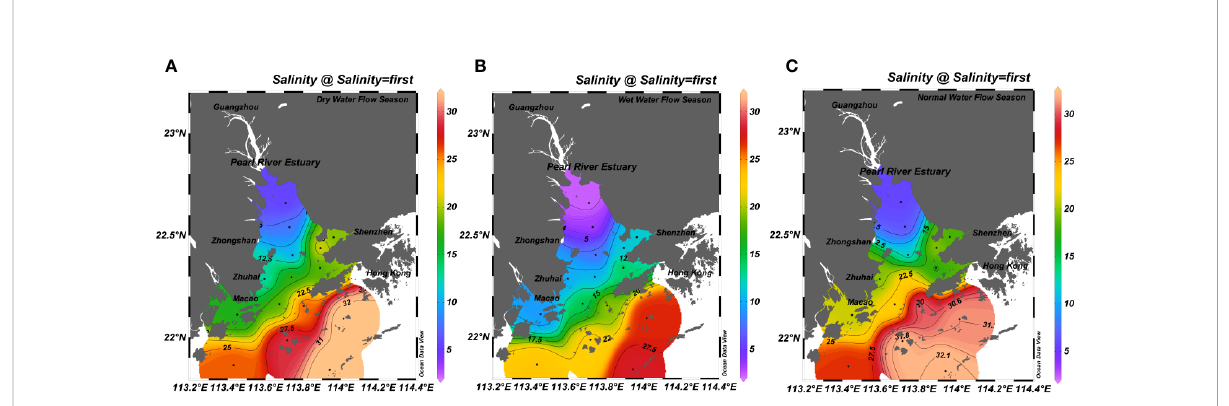
FIGURE 3 Spatial and temporal distribution of salinity along the PRE coastal water in the dry (A) , wet (B) , normal (C) season.